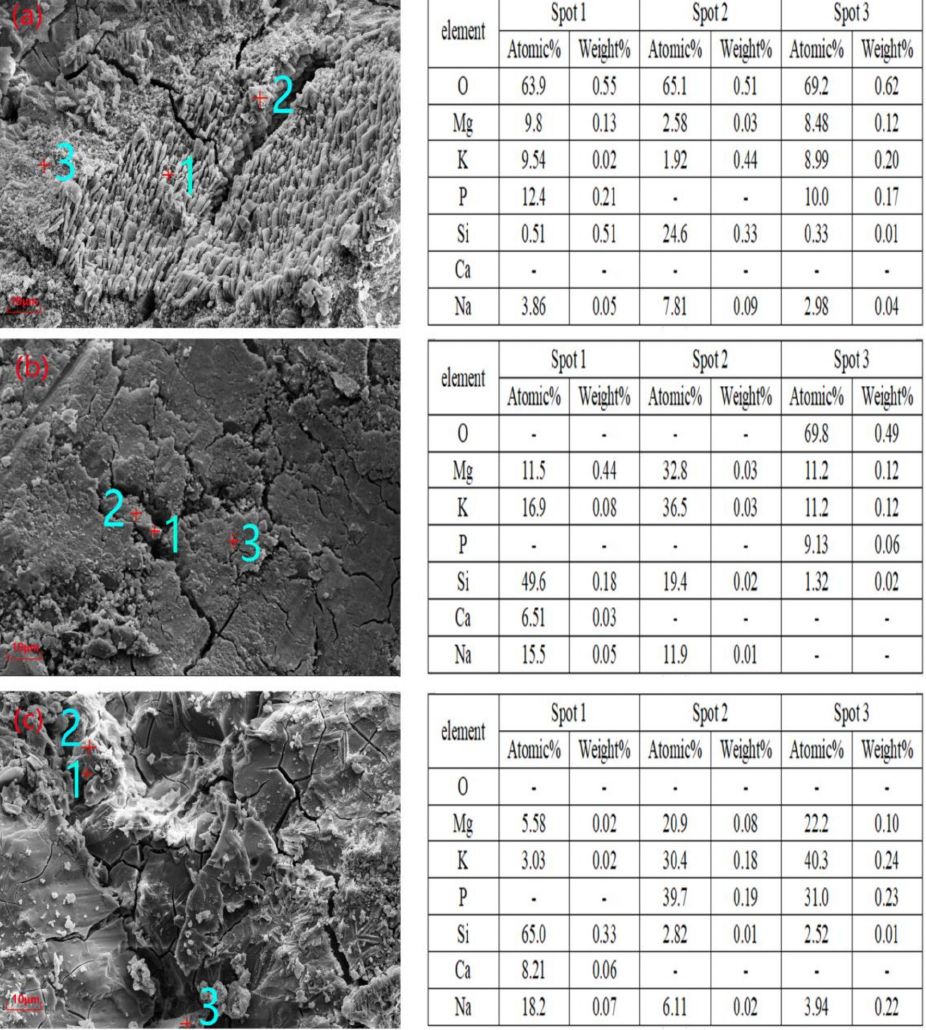
Figure 10. SEM-EDS analyses on spots of ( a ) G1-1, ( b ) G1-2, and ( c ) G1-4 cured for 28